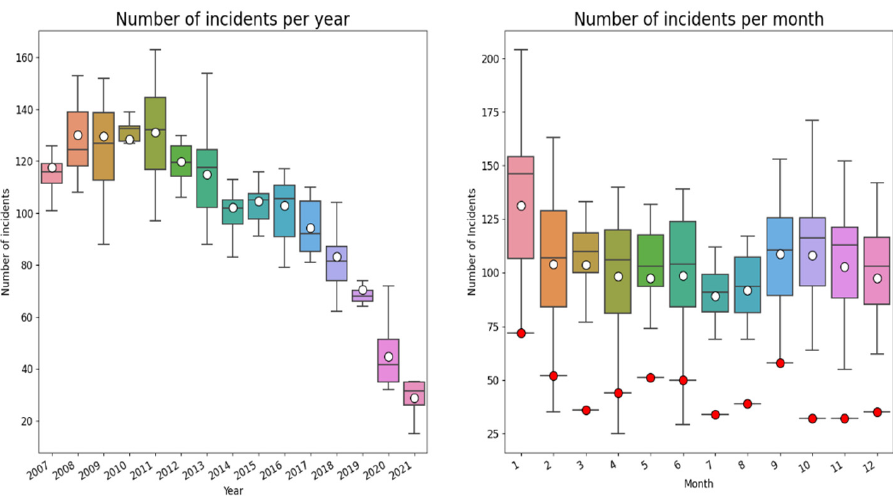
Figure 3. Year and month-wise box plot of reported incidents from 2007–2021. The number of incidents is in both graphs the number of incidents per month. The white dots indicate the mean number of incidents. The red dots are the number of reported incidents in 2020.